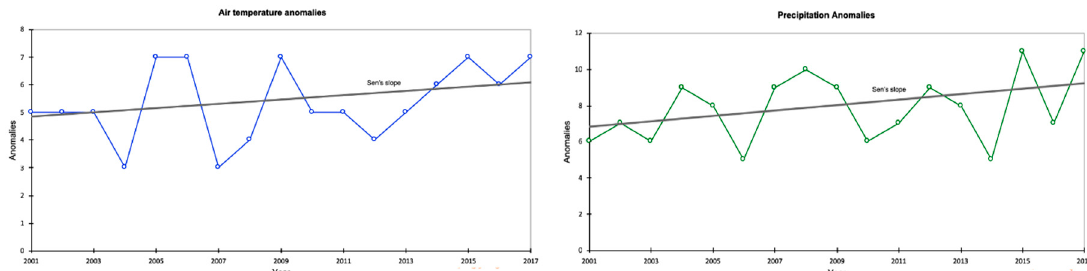
Figure 5. p -values. Figure 5. p-values.